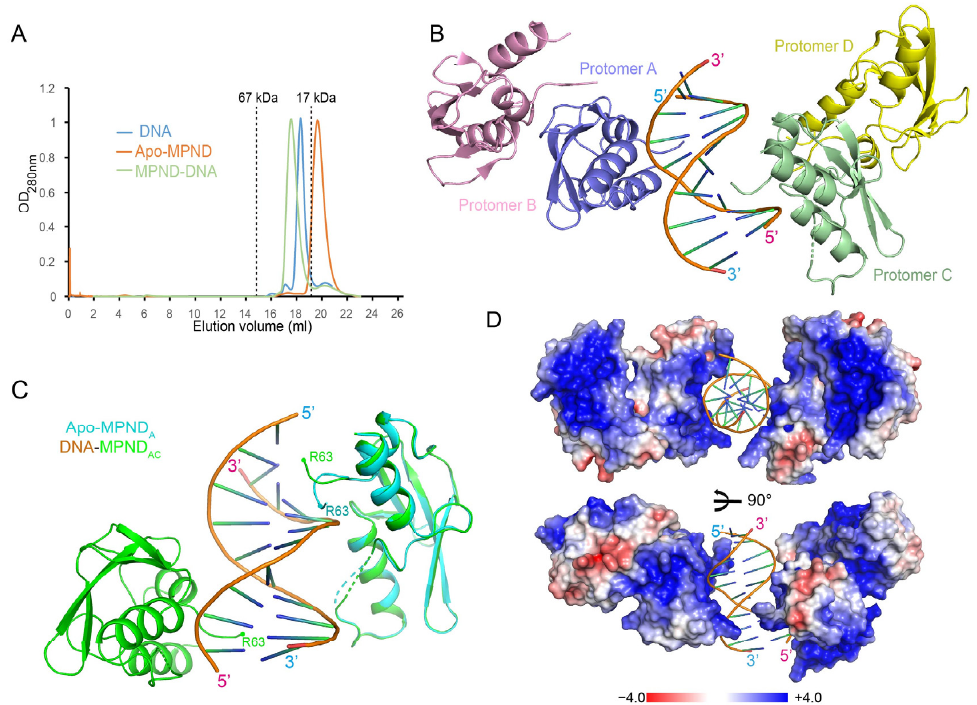
Figure 3. Structure of the MPND–DNA complex. ( A ) Size exclusion chromatography (SEC) of apo–MPND, DNA, and the complex on a Superdex TM 200 Increase 10/300 GL column. Elution volumes of the protein standards are marked at the top of the figure. ( B ) The ribbon representation of the MPND–DNA complex structure. ( C ) The superposition of the apo–MPND (cyan) and the MPND–DNA complex (MPND, in green) structures. ( D ) The electrostatic surface potential of the MPND–DNA complex at ± 4 kT/e: red (acidic), white (neutral), and blue (basic).